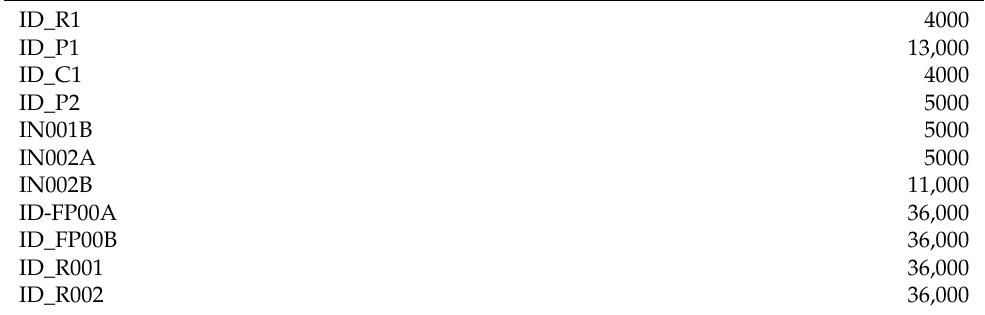
Table 11. Capacity data set of the Polymer plant, structuring two columns: Unit_ID and Data value.